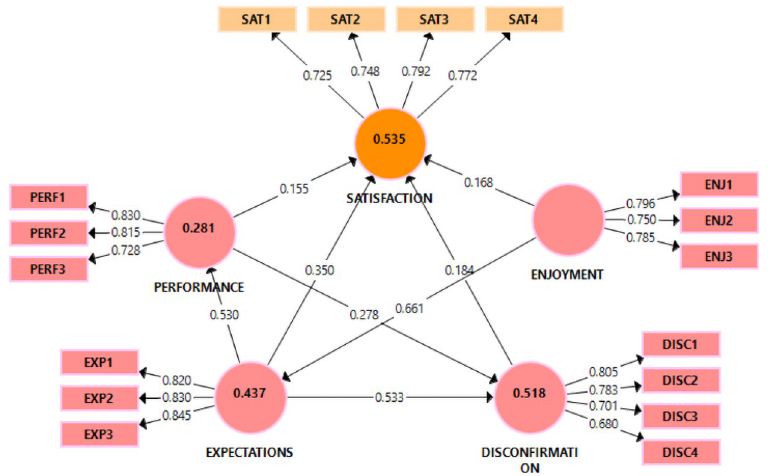
Fig 2. Final PLS-SEM structural model forecasting satisfaction with telemedicine.